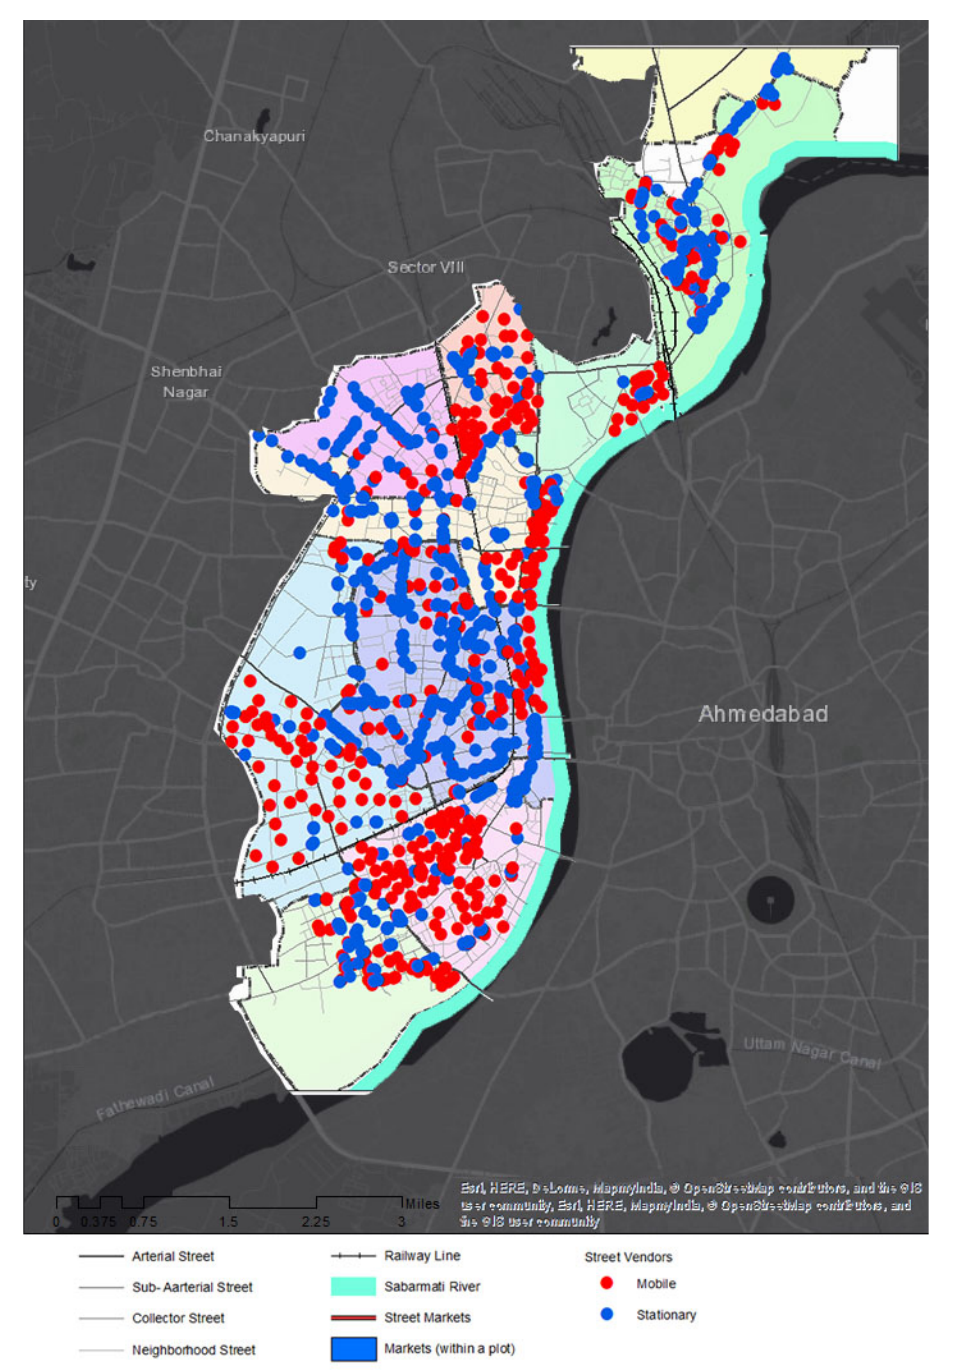
Figure 1. Nature of street vending: mobile and stationary. Source: field work.